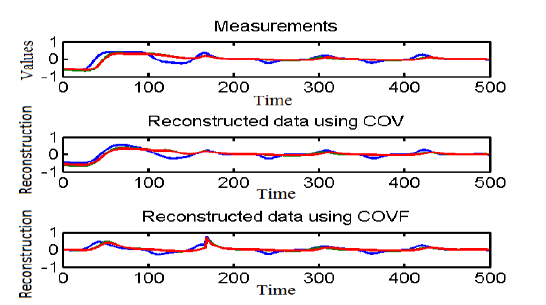
Figure 4: Reconstructed values and original measurements: chlorine data (blue: sensor 1, red: sensor 2)